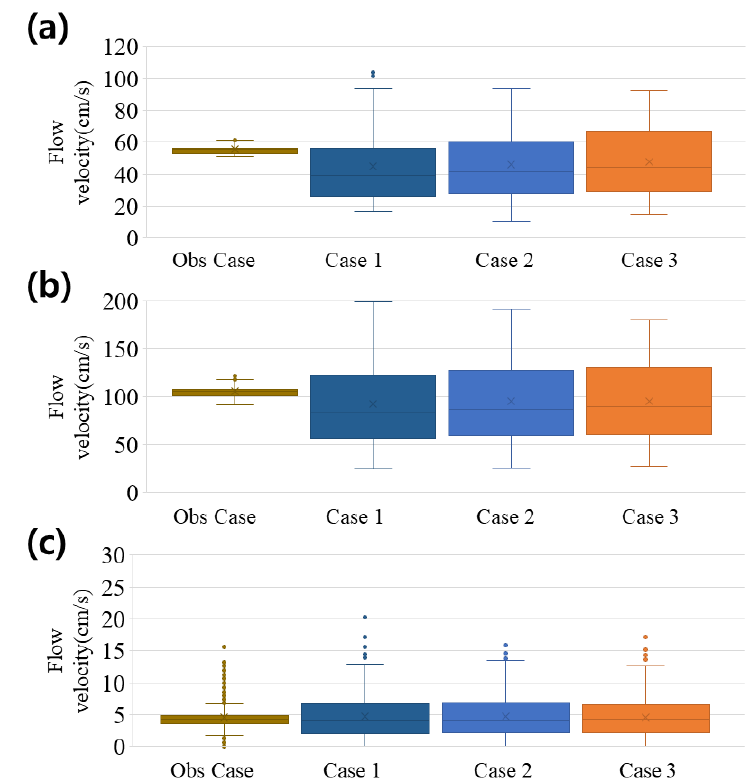
Figure 8. Flow velocity simulation results of the EFDC-NIER model: ( a ) Mokgye, ( b ) Seom River junction, ( c ) Gangcheon weir.